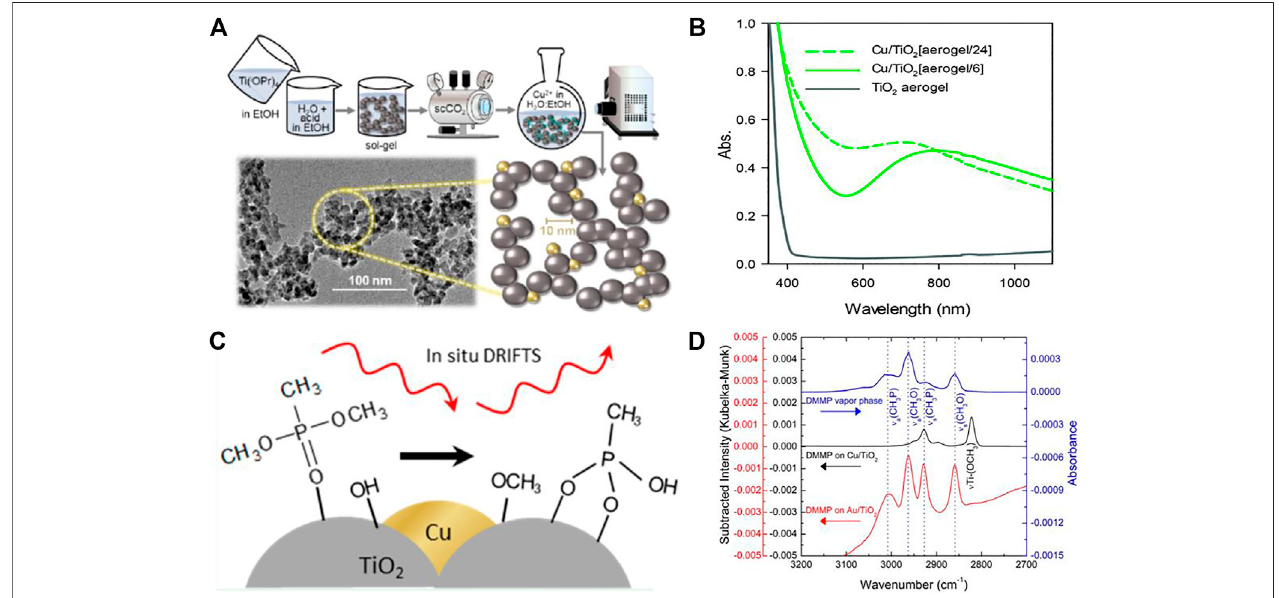
FIGURE 9 | (A) Synthetic schematic to prepare Cu/TiO 2 aerogels (inset: accompanying transmission electron micrograph of resulting composite aerogel). (B) UV – vis spectra for Cu NP-decorated and pristine TiO 2 aerogels. (C) Degradation pathway of DMMP over Cu/TiO 2 aerogels. (D) Spectrum of DMMP using diffuse re fl ectance infrared Fourier transform spectroscopy (DRIFTS) and DRIFTS difference spectra of DMMP-exposed Cu/TiO 2 and Au/TiO 2 aerogels. (A , C , and D) adapted from McEntee et al. (2020) with permission from the American Chemical Society. (B) adapted from DeSario et al. (2017) with permission from the Royal Society of